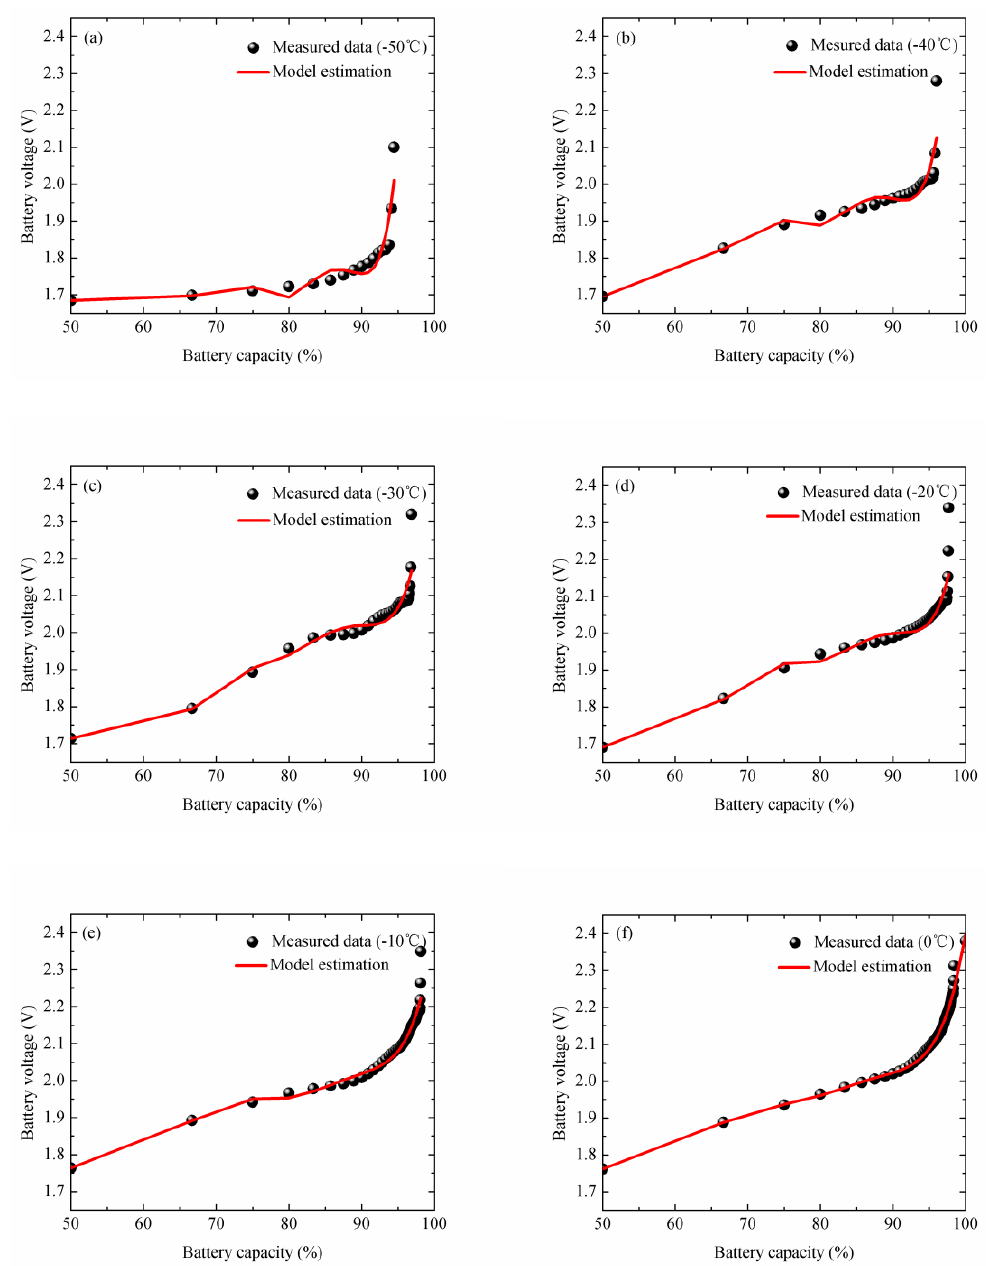
Figure 5. ( a – f ) show the relationship between battery voltage and battery capacity at − 50 ◦ C, − 40 ◦ C, − 30 ◦ C, − 20 ◦ C, − 10 ◦ C, 0 ◦ C,